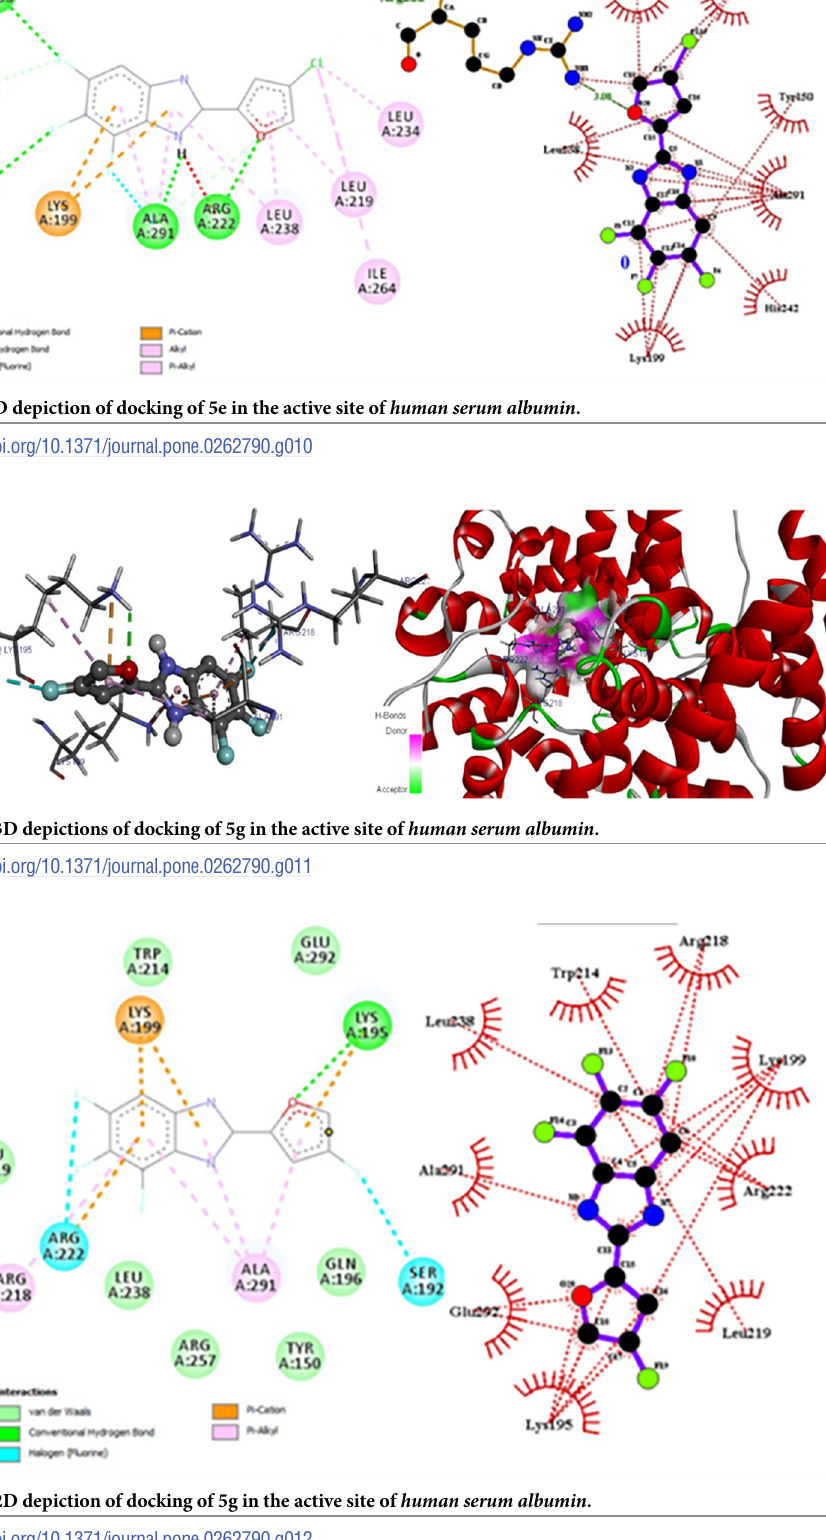
PLOS ONE | https://doi.org/10.1371/journal.pone.0262790 February 2,